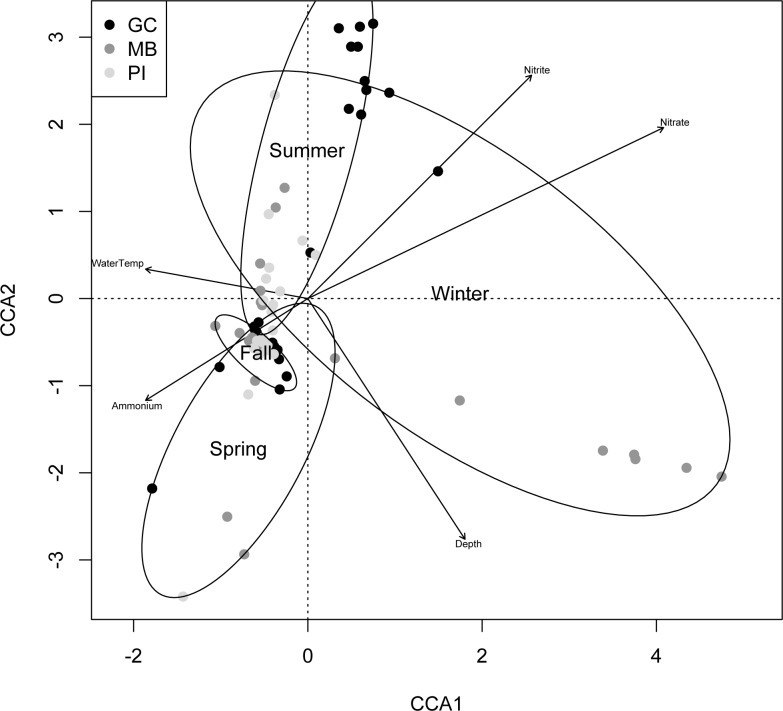
Canonical correspondence analysis (CCA) biplots of community structure of samples and environmental parameters.Parameters include water temperature, depth sampled, and concentrations of ammonium, nitrate, and nitrite in samples from Myrtle Beach (dark gray), Garden City (black), and Pawleys Island (light gray). Permutation tests were performed to determine significance of each parameter on community structure (p ≤ 0.05).